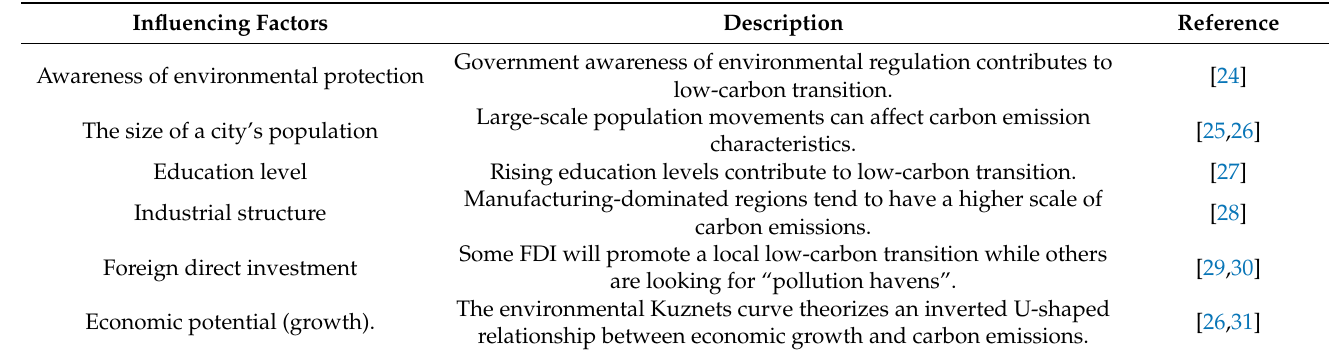
Table 1. Key factors affecting low-carbon